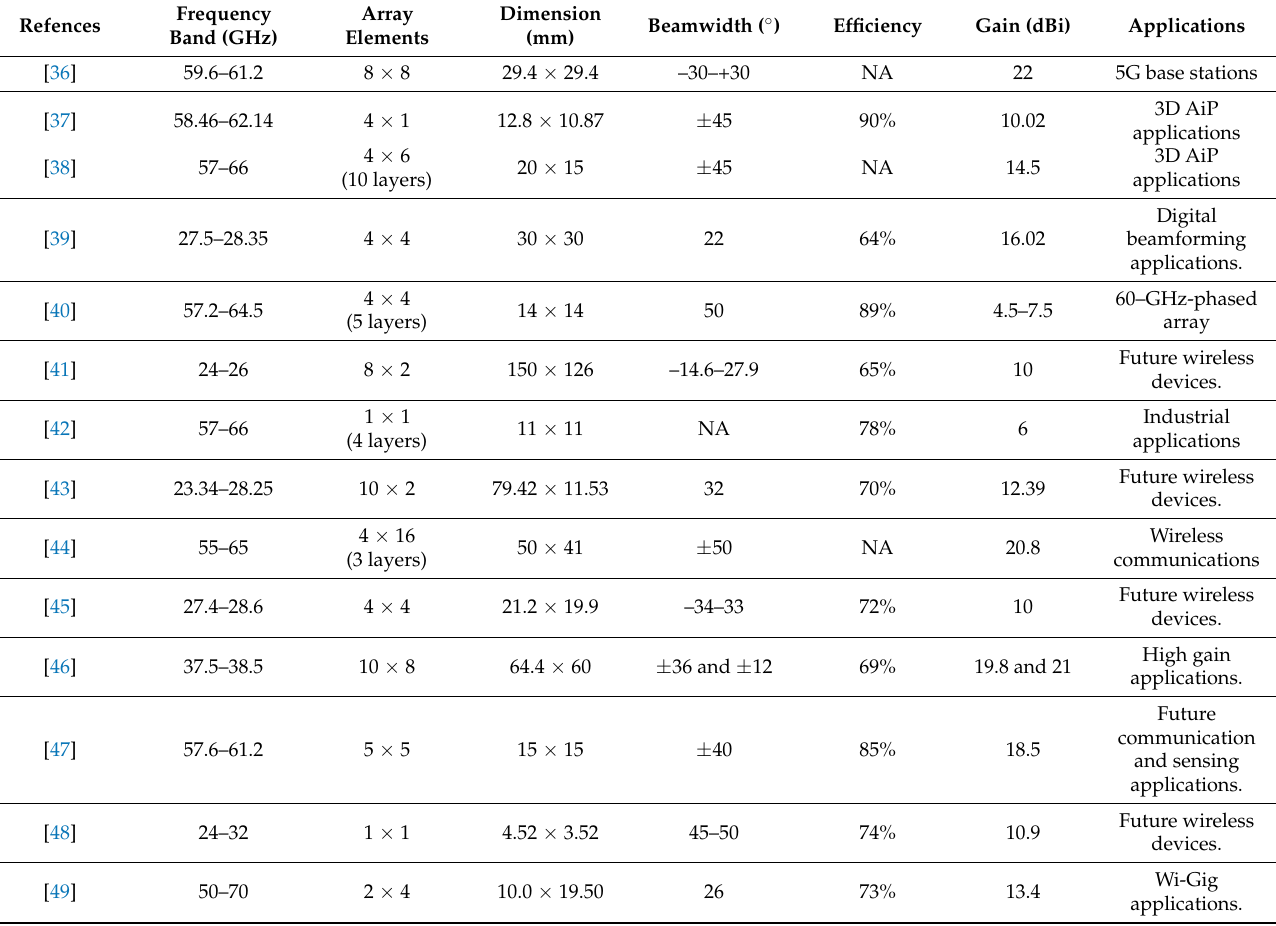
Table 7. Comparison between the proposed antenna and several mm-wave antenna